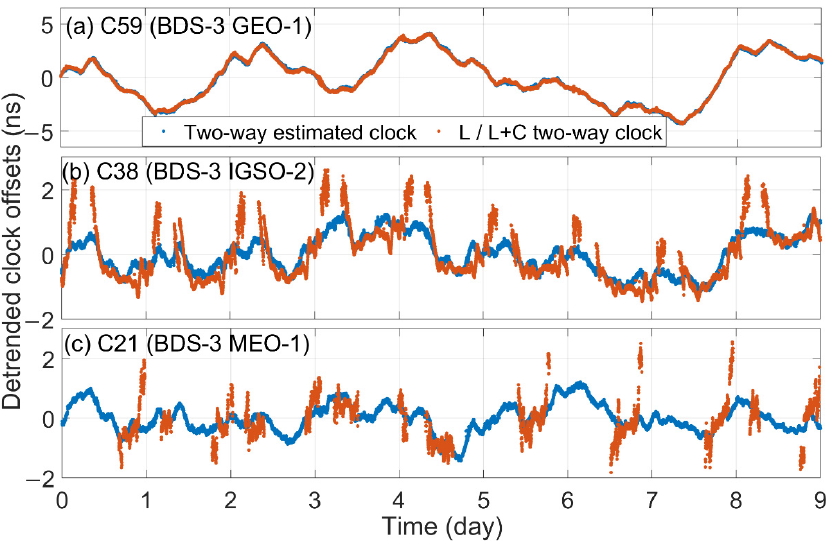
Figure 12. Satellite clock offset differences between the two-way estimated clock offsets and the two-way intraregional satellite clock offsets measured by superimposition strategy (since 19 May 2022). By comparing the two curves, it can be found that although the red curves are in